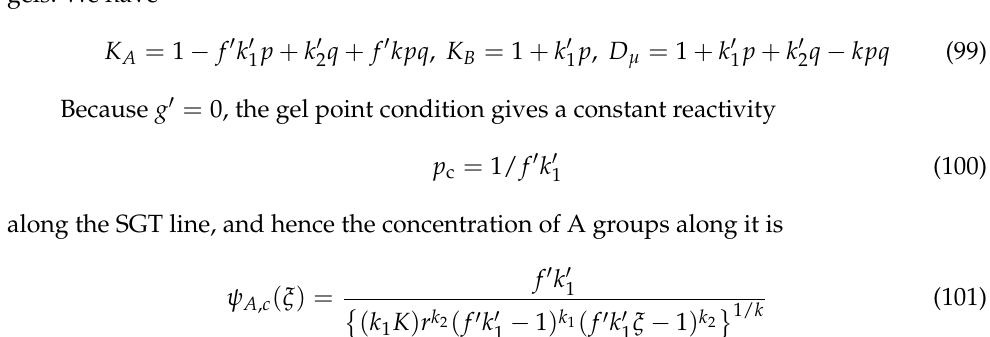
. Many A functional 1